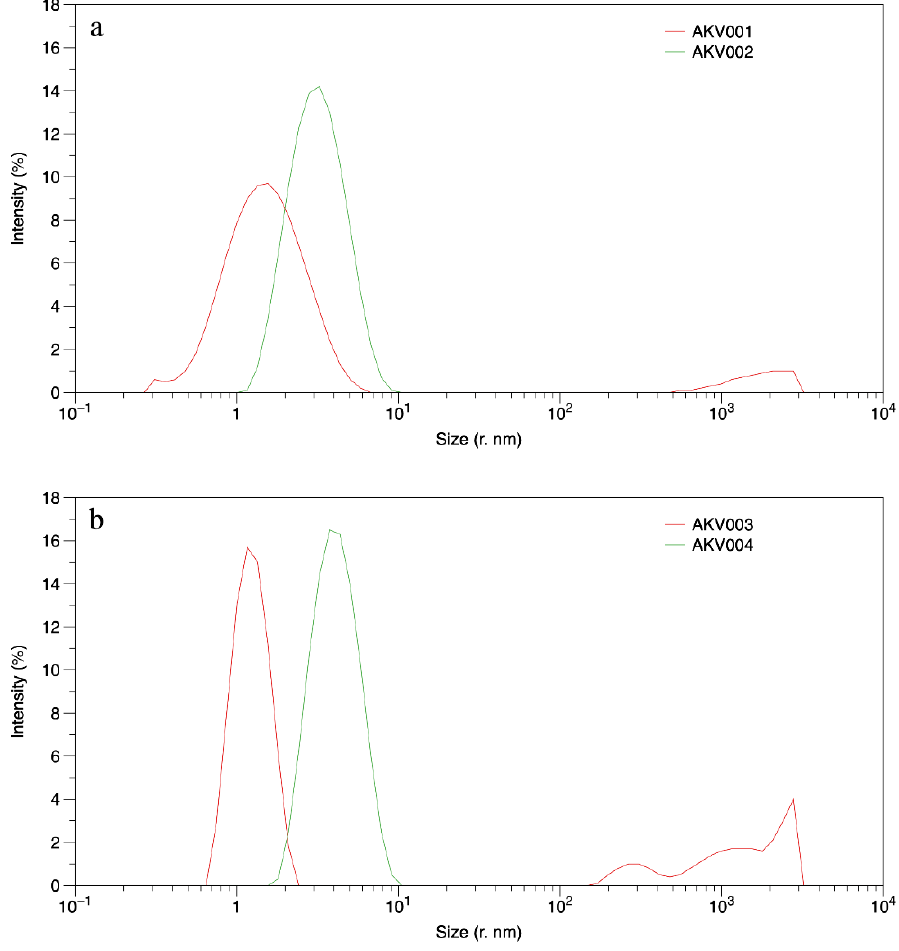
Figure 1. Average (triplicates) size distribution of AKVANO formulations based on DMPC (red) and DOPE (green) lipids, without ( a ) and with ( b ) additions of water, as measured by DLS meas- urements.